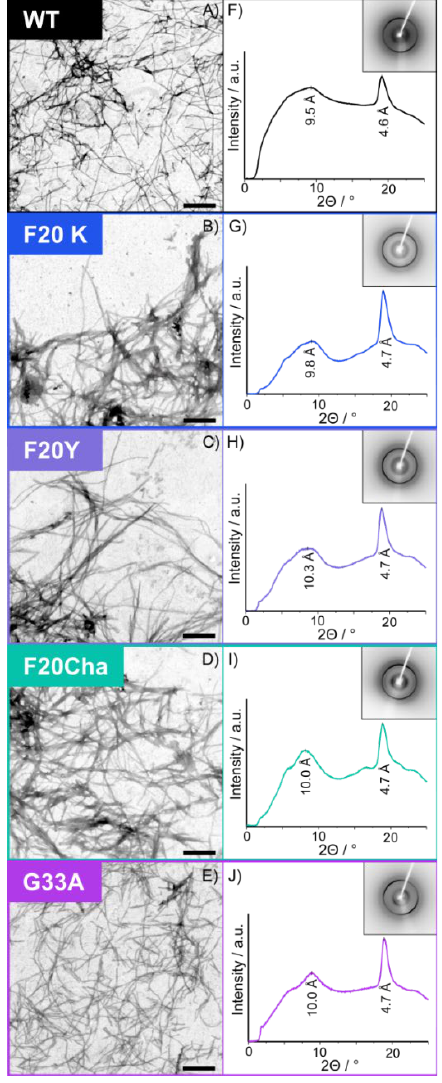
Figure 2. Transmission electron micrographs ( A – E ) and X-ray diffraction patterns ( F – J ) of fibrils of the Aβ 40 variants. The scale bar represents 400 nm.